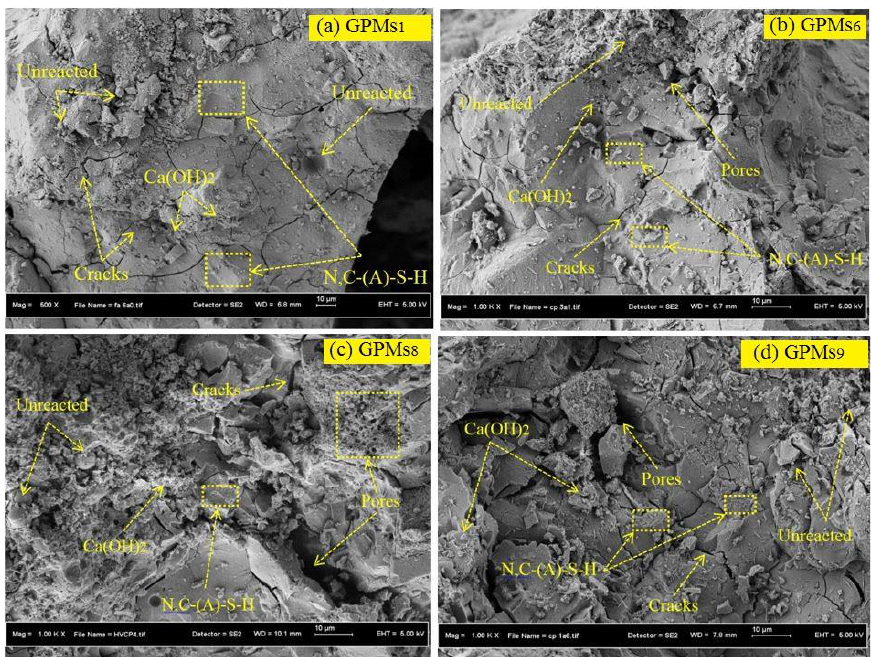
Figure 11. Effect of TCWs and FA as GBFS replacement on the surface morphology of prepared